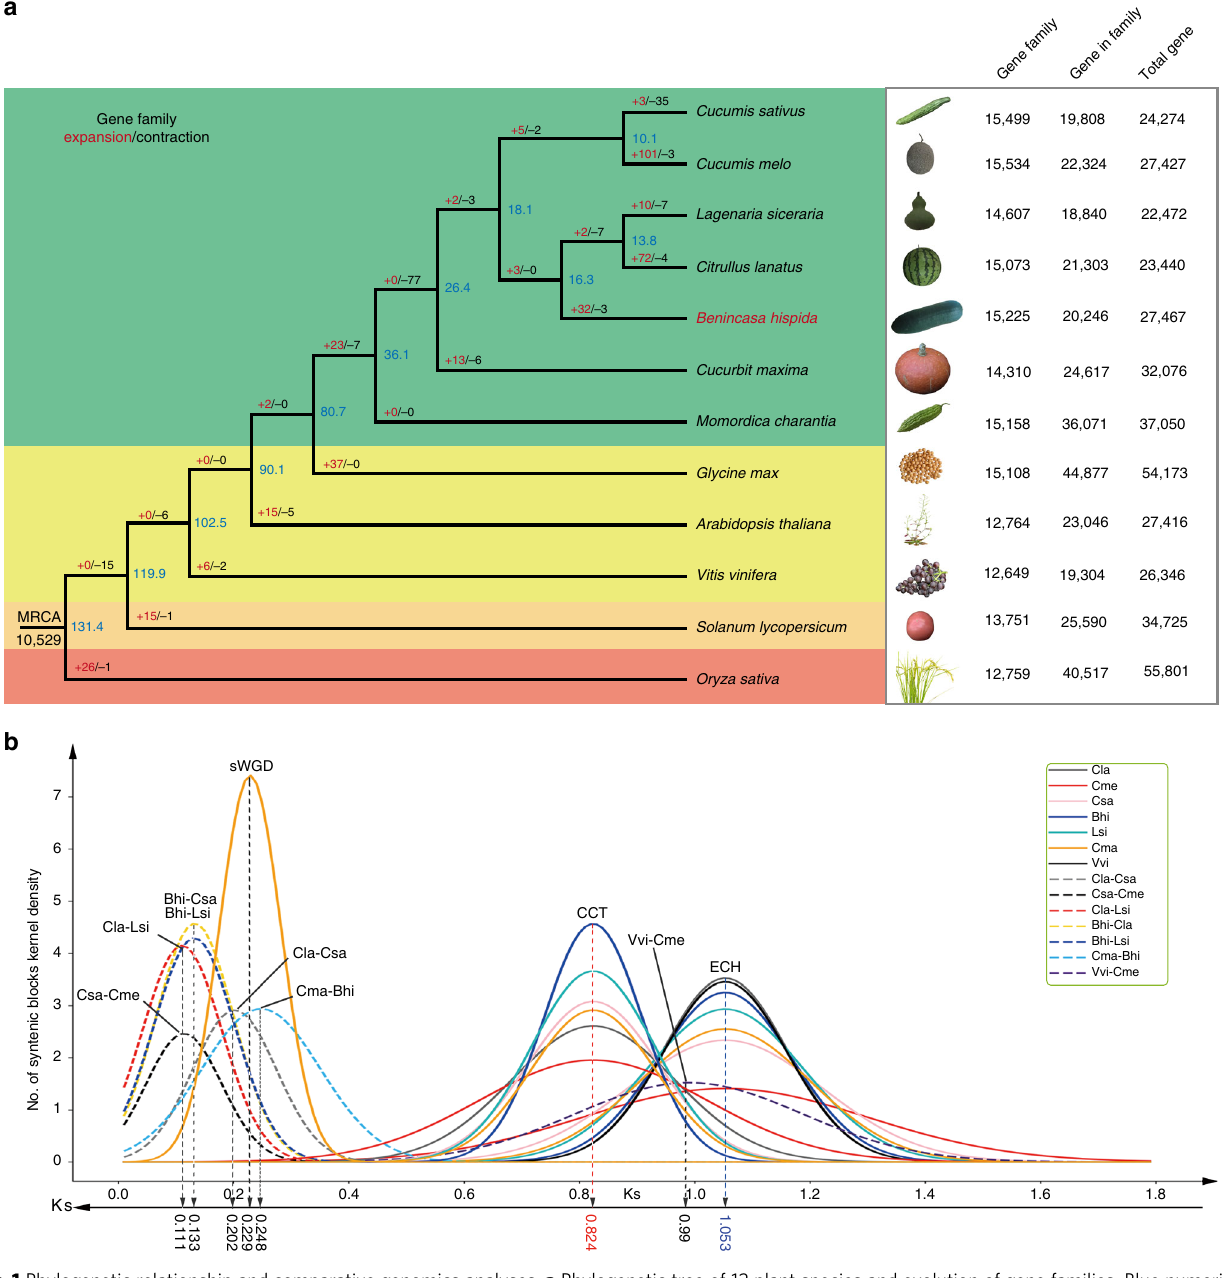
NATURE COMMUNICATIONS| (2019) 10:5158